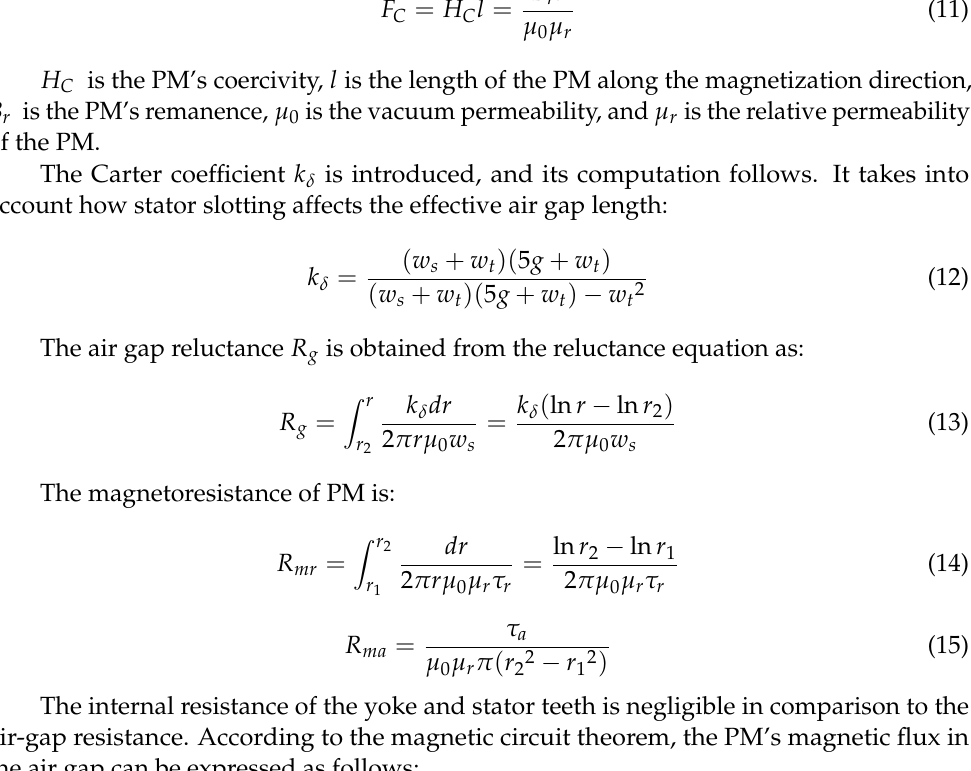
Figure 2. Equivalent magnetic circuit method.